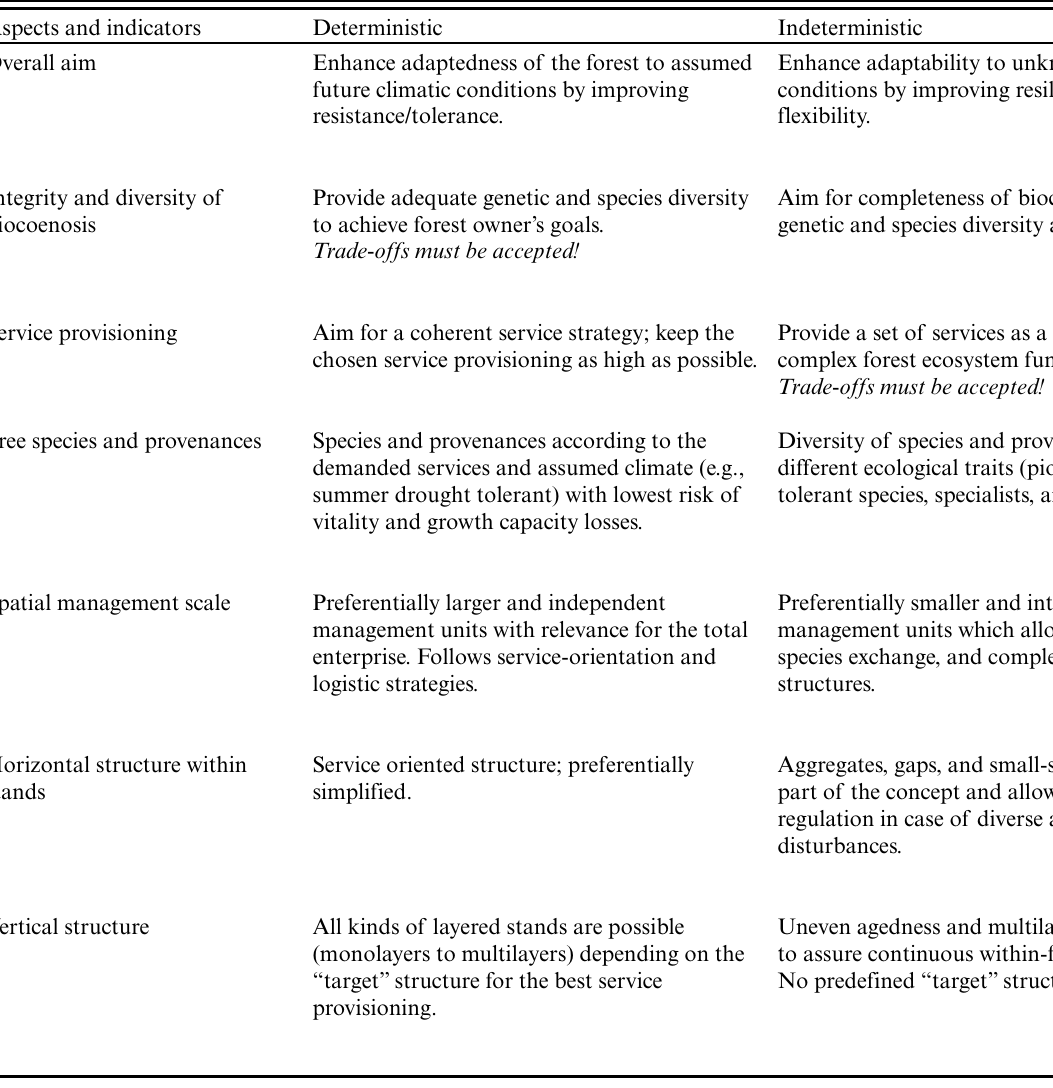
Table 1 . Comparison of deterministic and indeterministic approaches with emphasis on climate-change aspects; only relevant aspects for silvicultural management are considered. (Partial trade-offs with indicators must be accepted for both